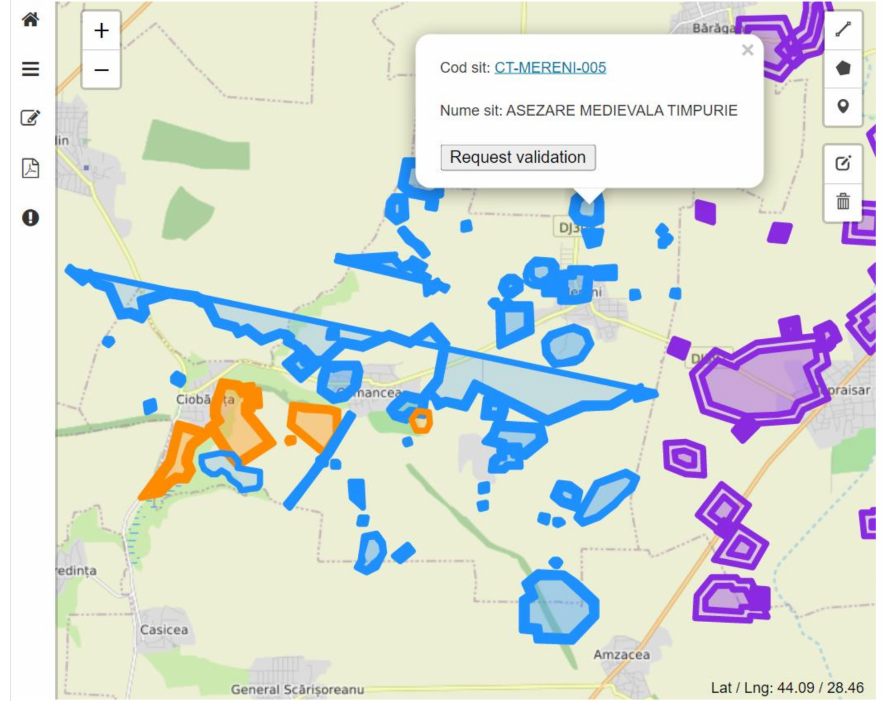
Figure 16. Archeological sites before requesting validation (blue), sites pending decision for validation (orange), and validated and publicly accessible sites (purple).